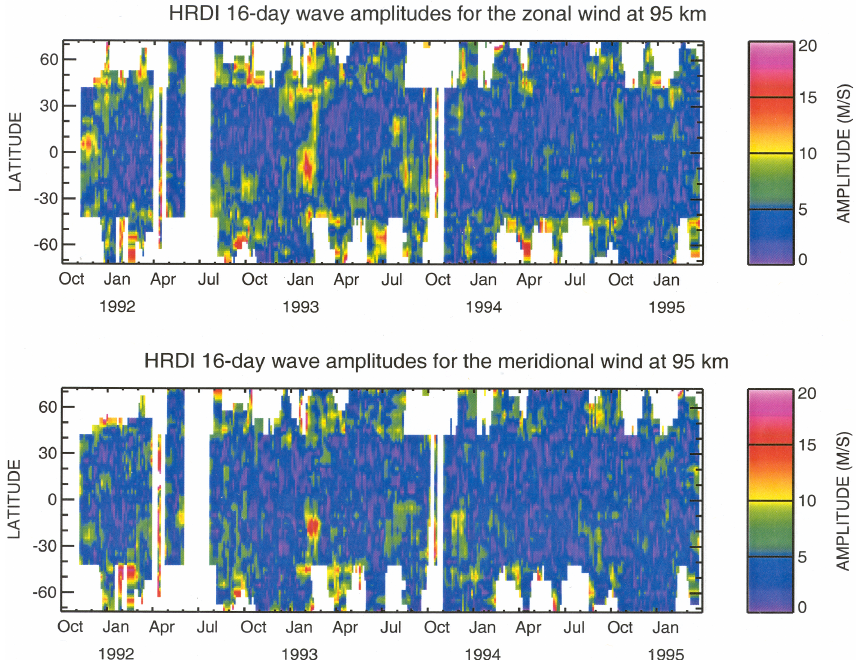
Fig. 10. The latitude-time amplitudes of the 16-day wave from HRDI wind measurements during 1992–1995. The amplitudes were produced by fitting a 16-day wave of zonal wave number 1 along each latitude circle, while using a 32-day time window and fitting every 4 ◦ in latitude. The upper panel is for the zonal wind, and the bottom is for the meridional wind.